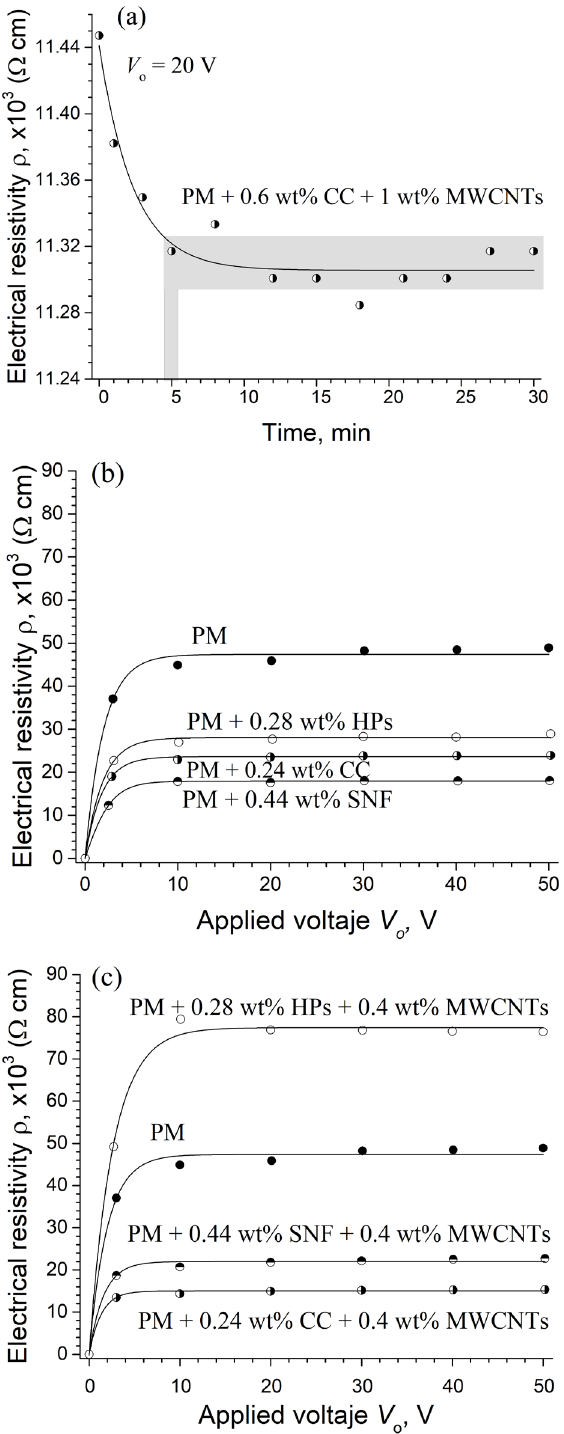
Figure 10 . (a) The elapsed time before resistivity stabilized. (b) Effects of chemical admixtures on the electrical conductivity of PM. (c) Effects of CAd+MWCNTs on the electrical conductivity of